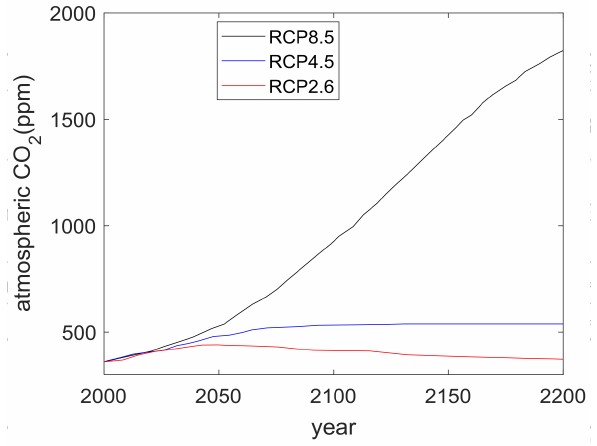
Figure 6. Global averaged CO 2 concentration rise. RCP: Representative Concentration Pathways.